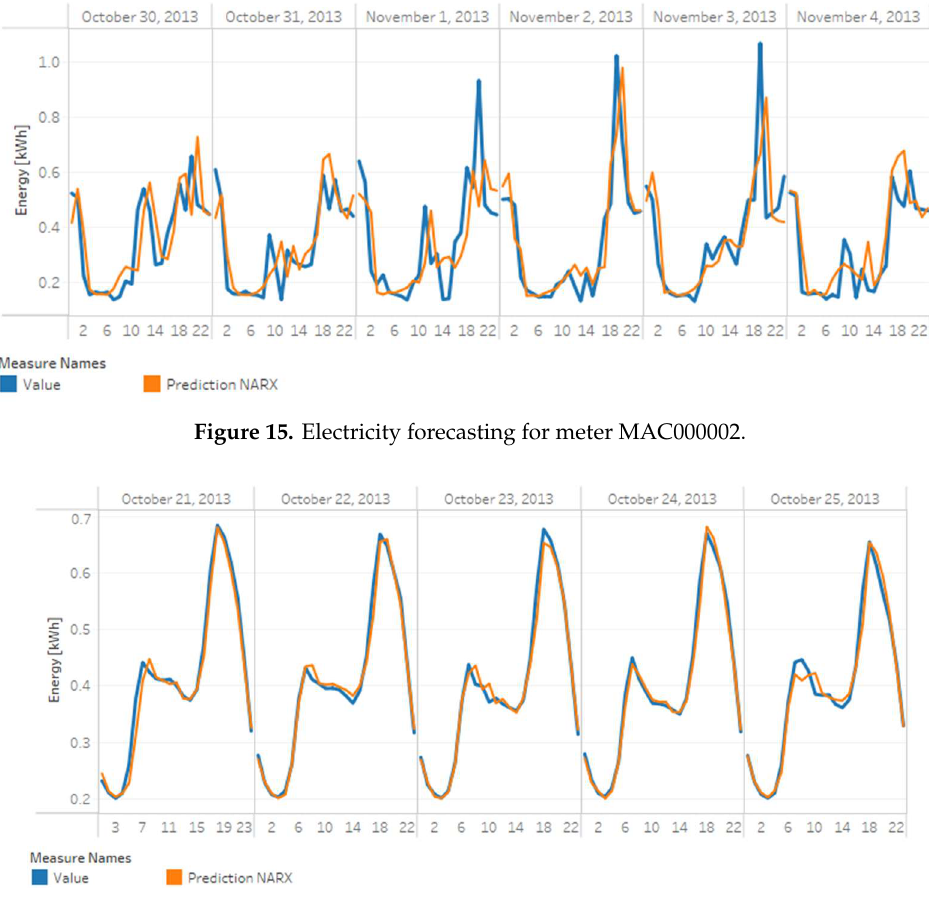
Figure 16. Electricity forecast for a comfortable category.